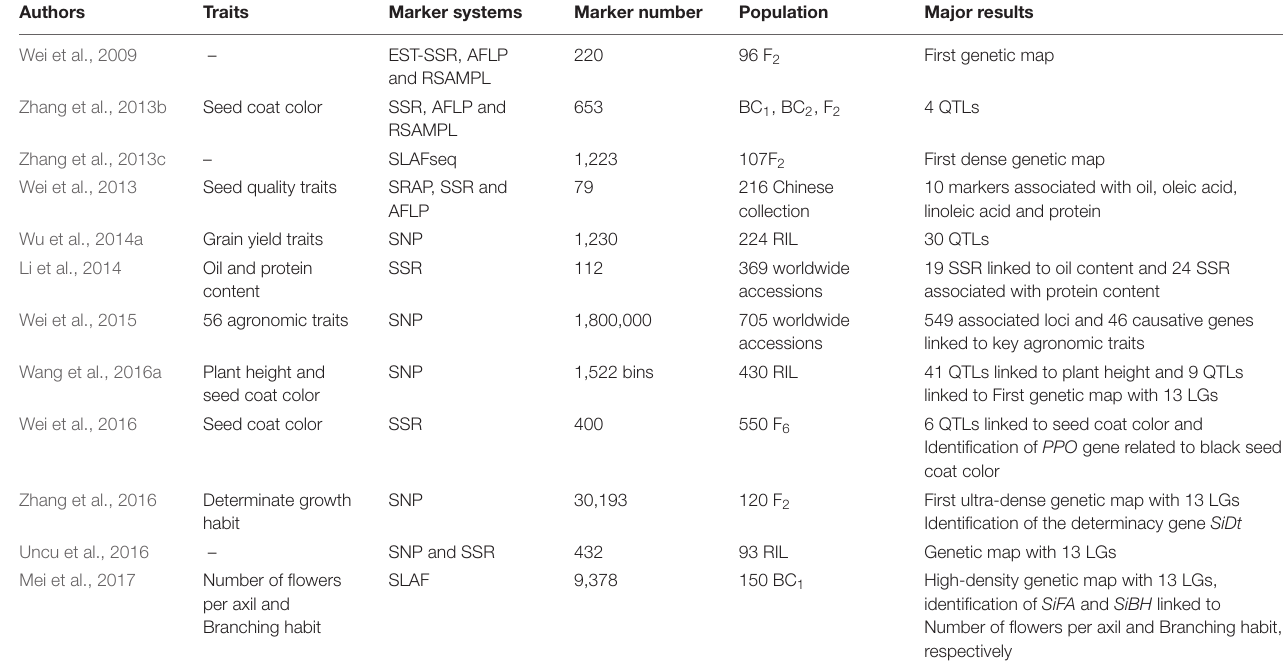
TABLE 3 | Genetic mapping and association mapping studies in sesame.